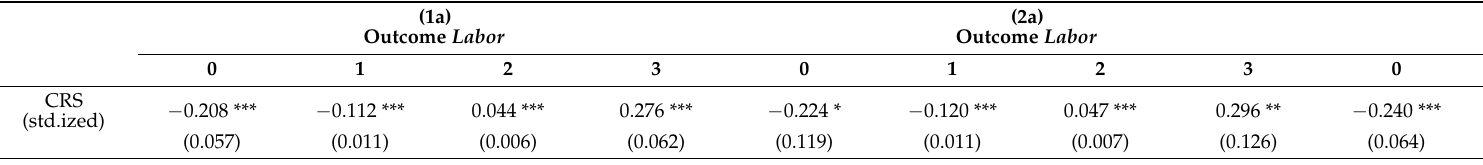
Table 9. Average marginal effect estimates for Table